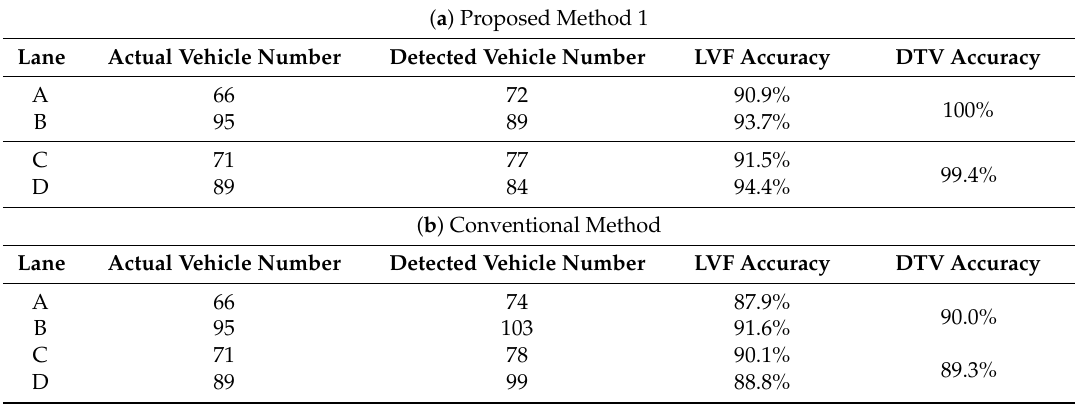
Table 11. Results of LVF and DTV detection during 7:50–8:00 PM (rush-hour traffic) using ( a ) proposed method 1 and ( b ) conventional method.